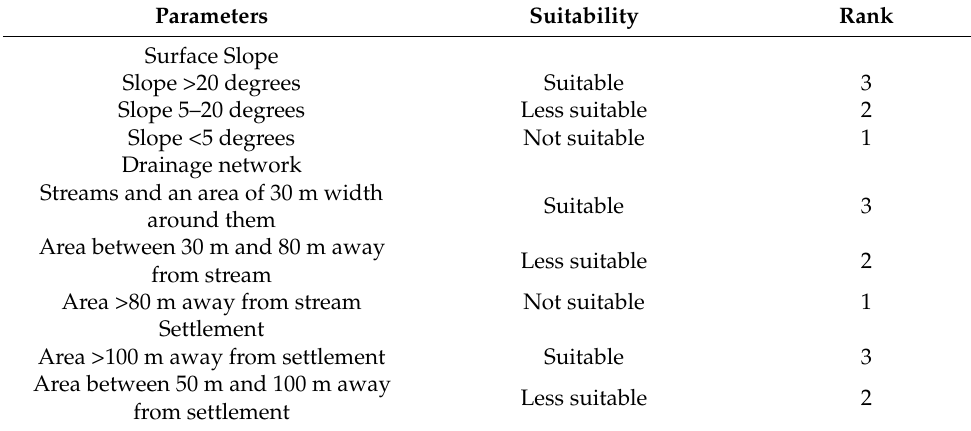
Table 3. Categorization and ranking for selecting suitable sites for Nigarims. Surface slope, drainage network, settlement, roads, runoff volume, and rainwater results are classified into three categories— suitable, less-suitable and not-suitable classes—based on criteria rationally set by IMSD (1995), INCOH (1995), and FAO (2003) (source: Bhaumic and Rao 2003, Rao et al., 2008)